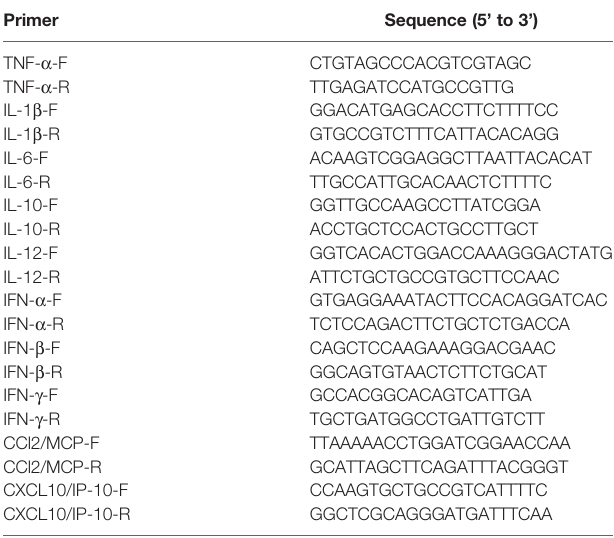
TABLE 1 | List of primers used in the qRT-PCR assay for cytokines, chemokines, and IFNs.